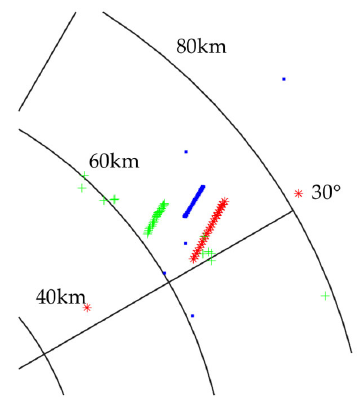
Figure 7. Three tracks in the radar 3 coordinate system, where green line (plus) is detected by radar 1, blue line (dotted) is detected by radar 2, and red line (asterisked) is detected by radar 3.